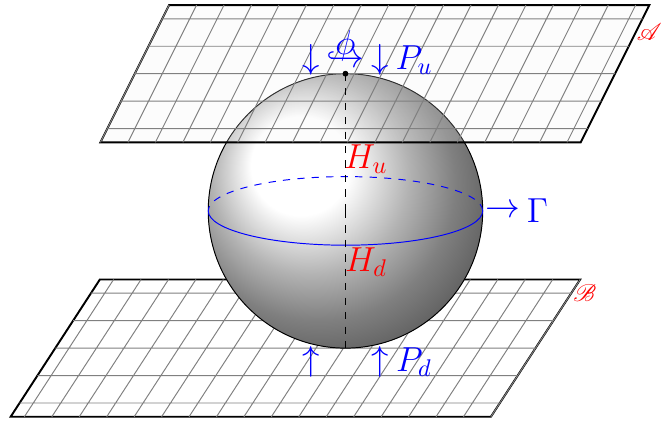
Figure 2. The projection of the eight-vertex Baxter model from the two sub-lattices to the S 2 surface of the